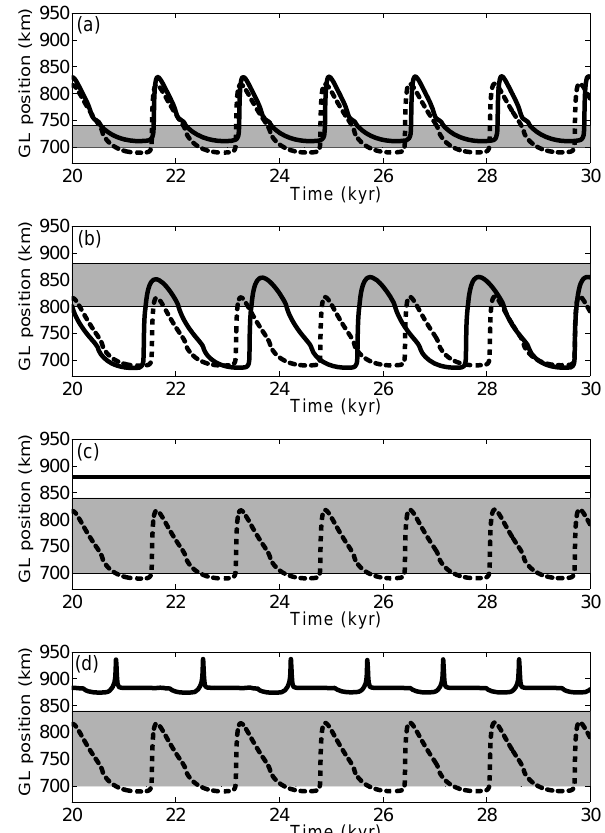
Figure 3. Four representative examples of interaction between ret- rograde section and ice-stream thermal oscillations. In all panels, the solid line is simulated grounding-line migration after transient initialization period ( t < 20kyr), the dashed line is grounding-line migration in baseline simulation run without any retrograde sec- tion ( L = 0km) and the grey shaded area is the extent of retro- grade section. (a) Minimally modified thermal oscillations with ice-stream persistence on the retrograde section during stagnation ( b x r = 2 × 10 − 4 ). (b) Amplified thermal oscillations with part of active phase on retrograde section ( b x r = 2 × 10 − 4 ). (c) Suppressed thermal oscillations ( b x r = 6 × 10 − 4 ). (d) Thermal oscillations with reduced amplitude ( b x r = 8 × 10 − 4 ). All examples are initialized with x g =